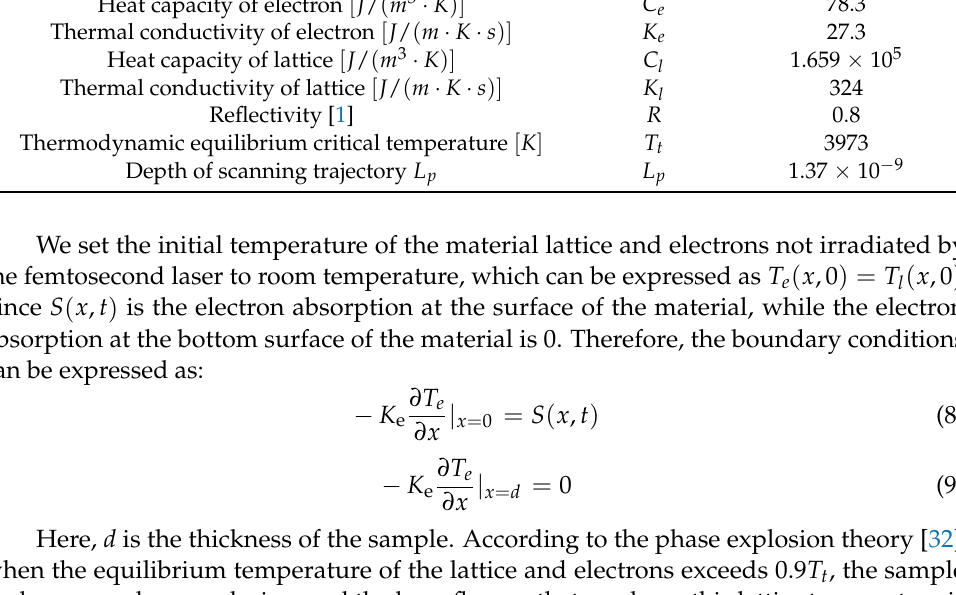
Figure 3. Schematic diagram of path planning for femtosecond laser polishing.